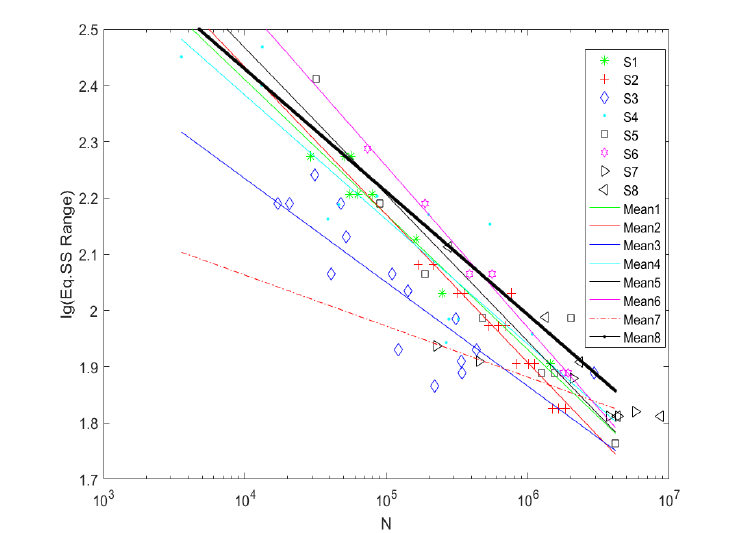
Figure 11: S-N curve cluster based on the fatigue characteristic domain.